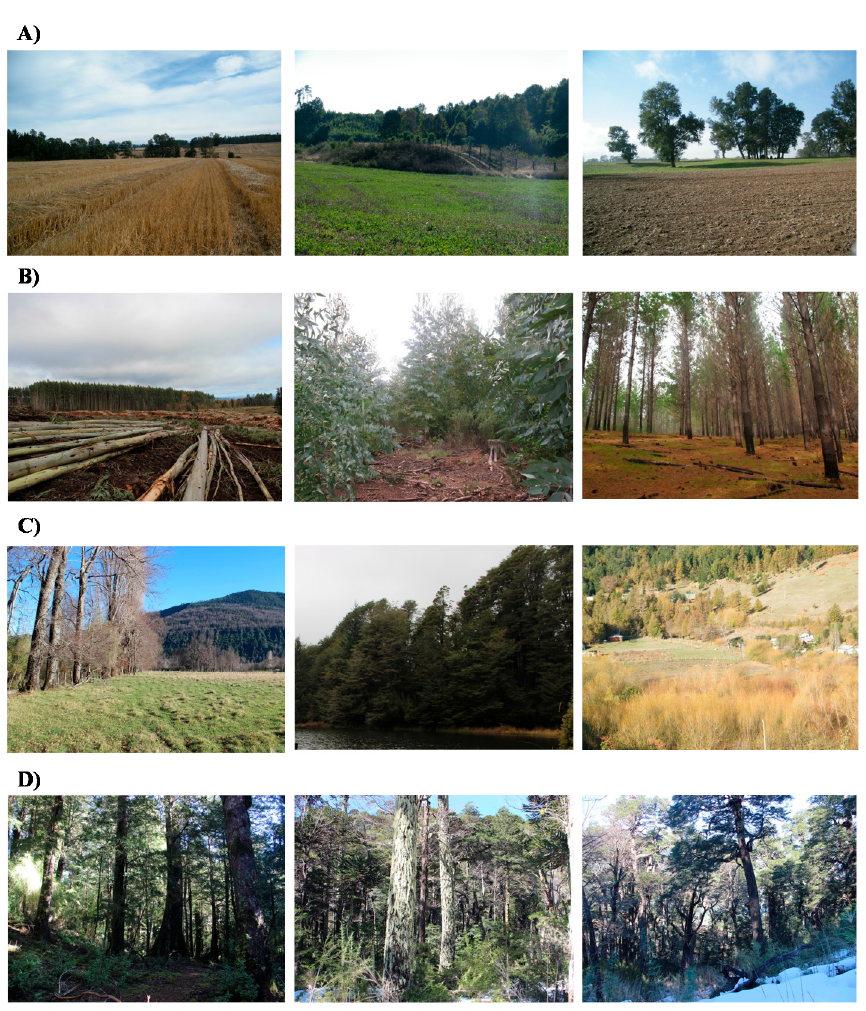
Figure A1. Eye-level images used: ( A ) Freire, ( B ) Lumaco, ( C ) Pucón, ( D ) Curarrehue.